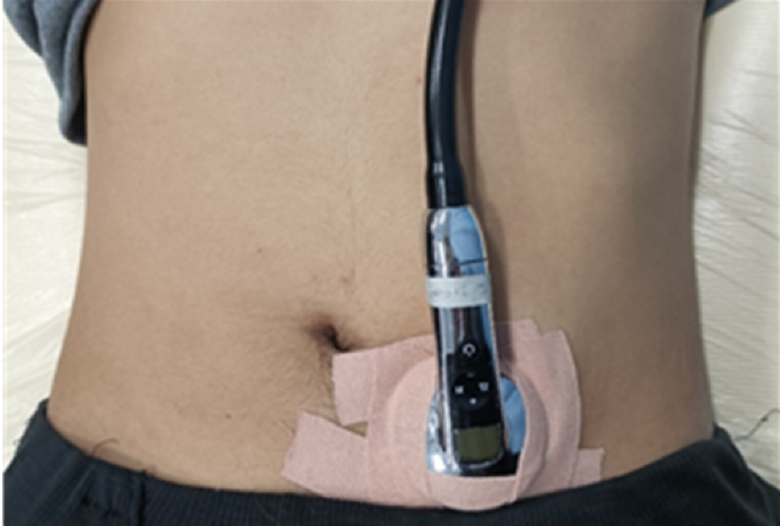
Figure 9. Bowel sound signal measured with an electronic stethoscope.